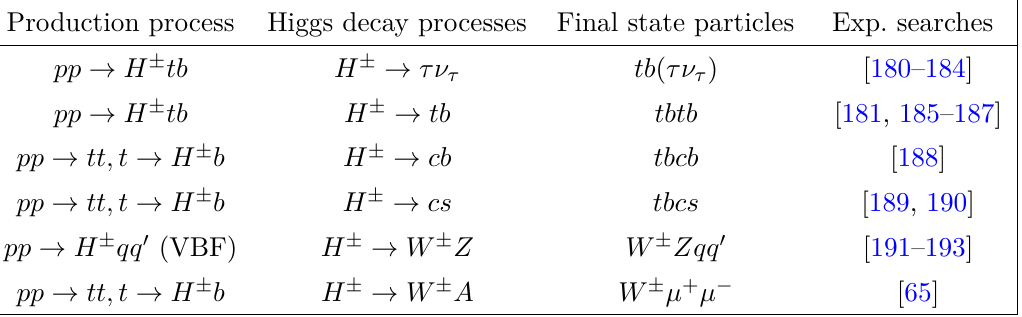
Table 3. Experimentally covered LHC signatures for a (singly) charged Higgs boson, H ± .